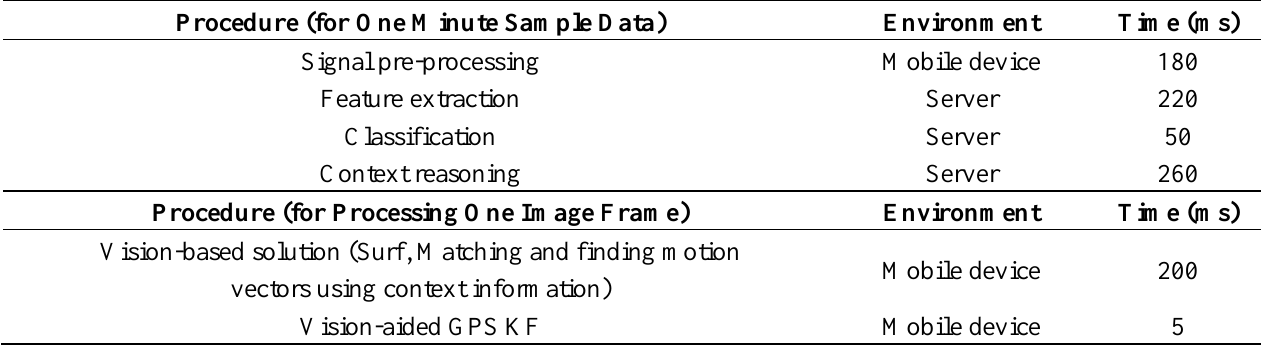
Table 9. Time efficiency of different steps in context recognition and vision-aided